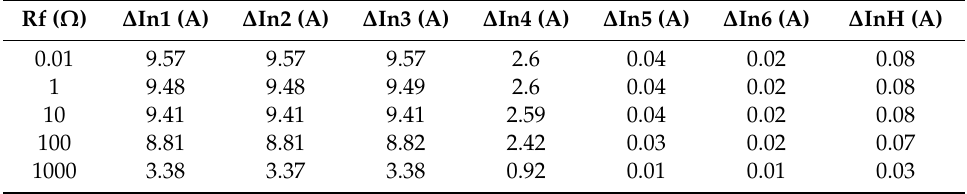
Table 1. Negative sequence currents in urban compensated network.